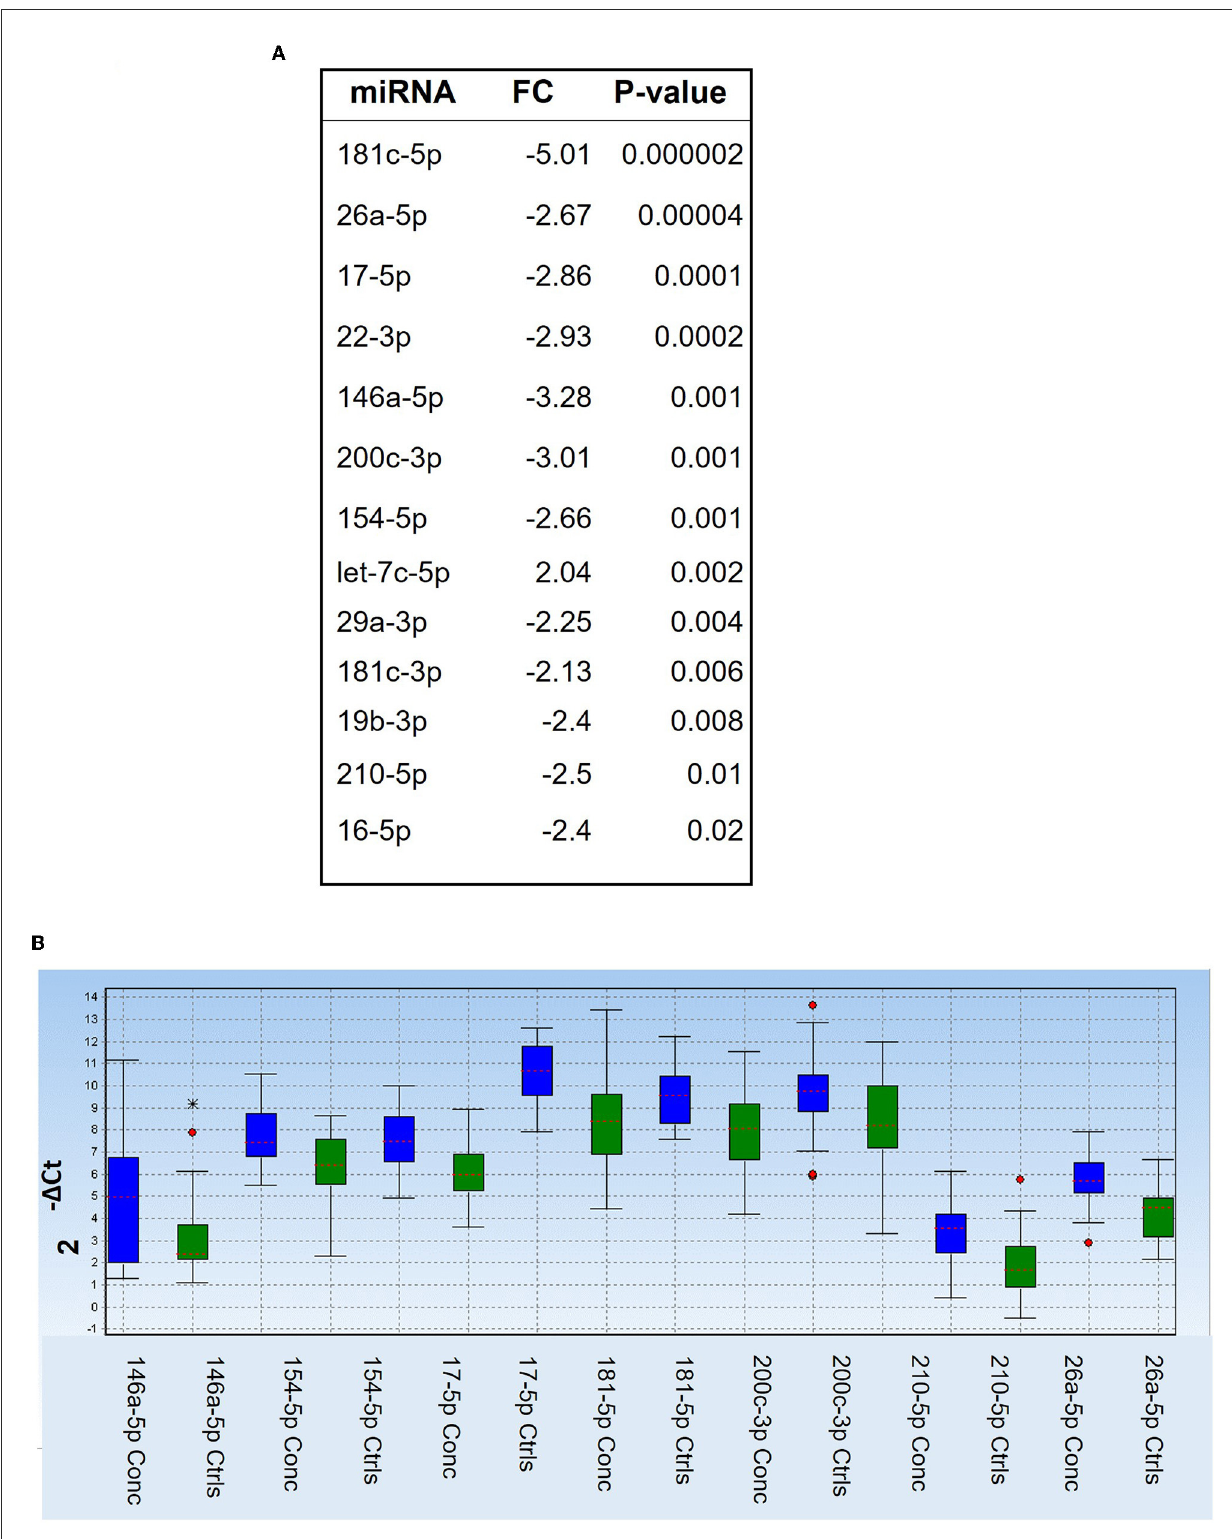
FIGURE1 Differentially regulated miRNAs in concussed players compared to controls. (A) List of differentially regulated miRNAs at all combined timepoints, as determined by Mann-Whitney test. FC: fold change (2 − 11 Ct ). P -values are shown in the right column. (B) Box plot showing relative expression (2 − 1 Ct ) of the selected miRNAs in the two groups of concussed ( n = 27; blue) and control players ( n = 29, green). Each box shows the distribution of the measured miRNA value across the samples. The red dotted line in each colored box represents the median value. Red dot stars identify outliers and extra outliers,